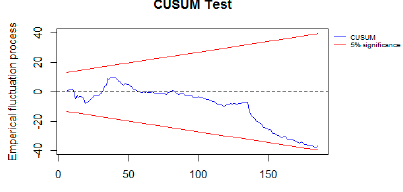
Figure 6. CUSUM test of fruit yogurt.